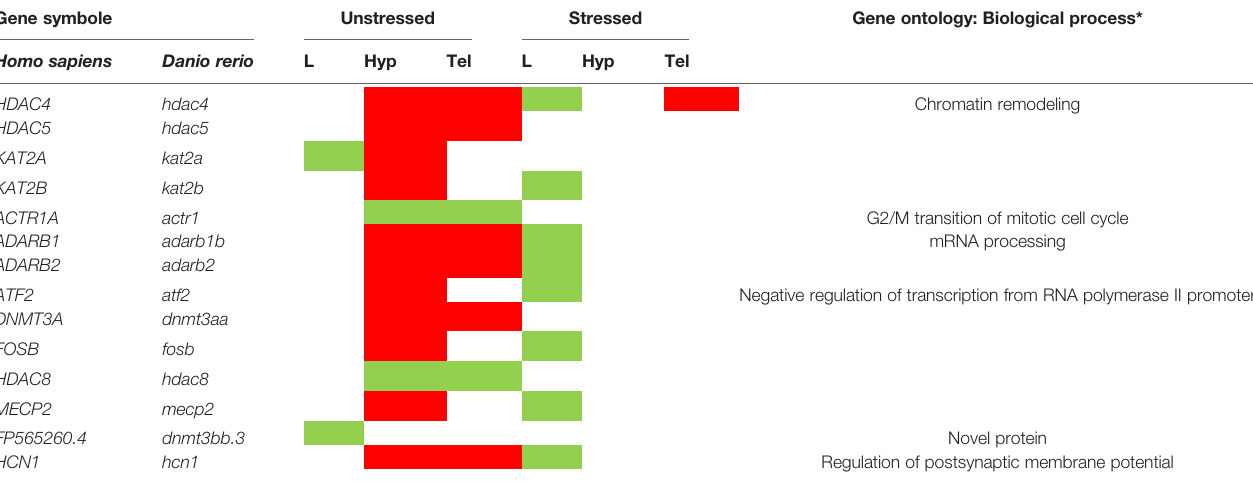
TABLE 3 | Life-long dysregulation of genes involved in epigenetics following developmental exposure to fl uoxetine. Gene symbole Stressed Gene ontology: Biological